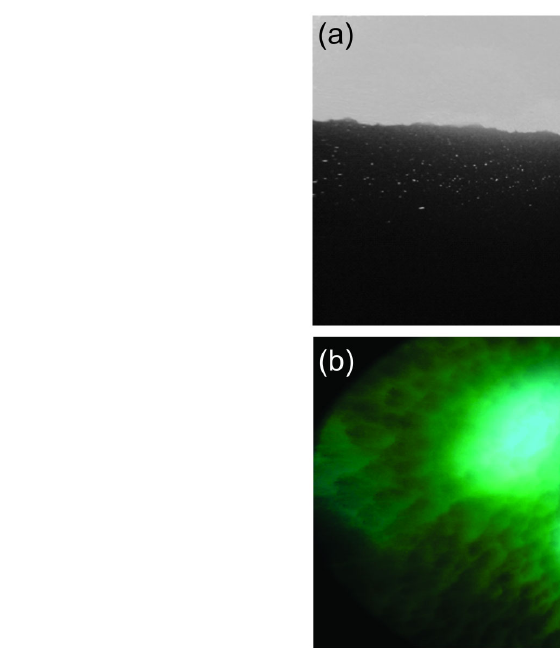
FIGURE 6 video stills showing (A) beneath ice showing suspended crystals (approximate horizontal fi eld of view 5 m). The image has had its contrast manipulated to aid in identi fi cation of the crystals. (B) An upward looking image showing the underside of the SIPL. The square in the middle is 1 m x 1 m and the bright patches are where snow was cleared for the camp. Undulations were apparent at the 2-3 m scale (approximate northward direction identi fi